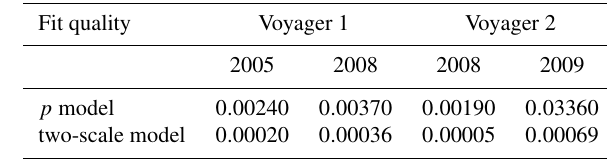
Table 1. The measure of chi-square fitting for the weighted two- scale and one-scale p